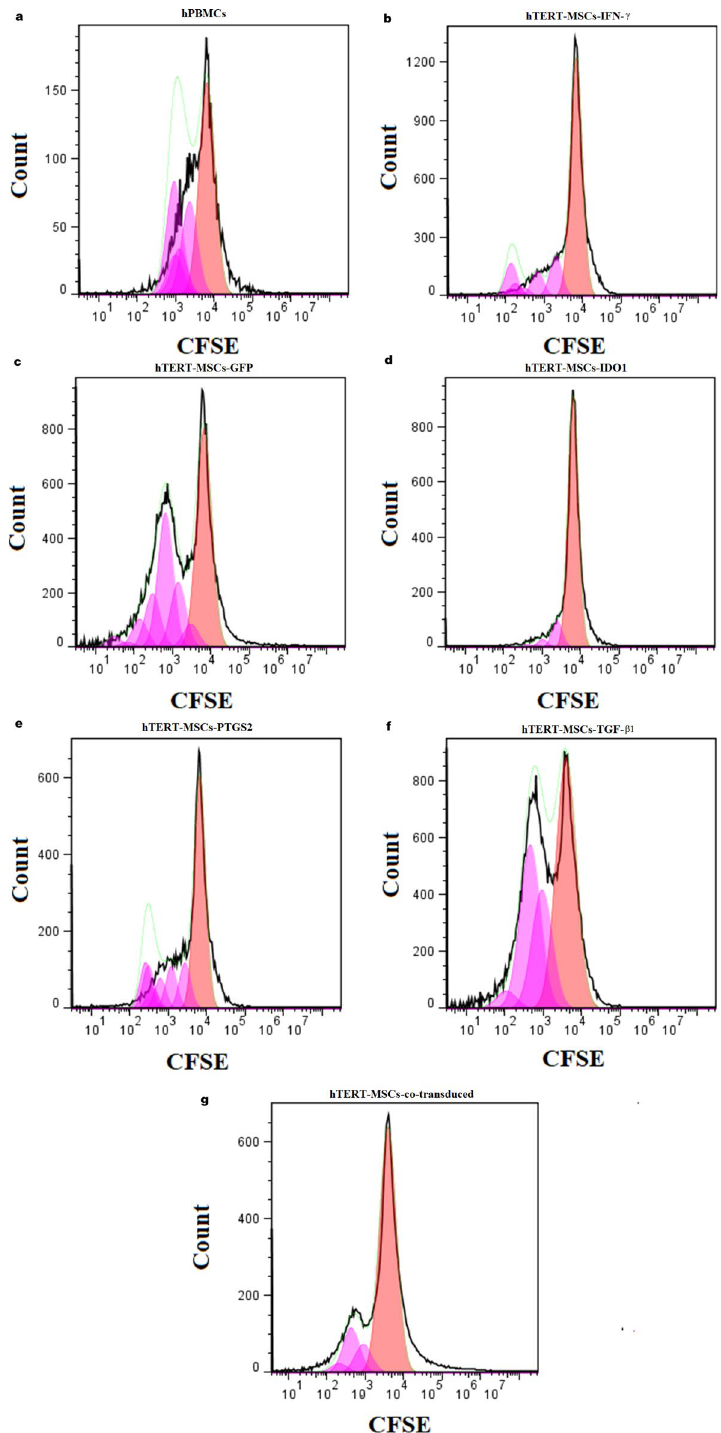
Figure 8. Lymphocyte inhibition assay (CFSE analysis). Results from flow cytometric analysis of the inhibitory effects of hTERT-MSCs against human PBMCs following 2 days of co-culture experiments. CFSE-labelled human PBMCs cultured ( a ) in the absence of any cells or in the presence of ( b ) hTERT-MSCs-IFN-γ (250 U/ ml), ( c ) hTERT-MSCs-GFP, ( d ) hTERT-MSCs-IDO1, ( e ) hTERT-MSCs-PTGS2, ( f ) hTERT-MSCs-TGF-β1 and ( g ) hTERT-MSCs-co-transduced. As shown hTERT-MSCs-IDO1 demonstrated the highest level of lymphocyte inhibition followed by hTERT-MSCs-co-transduced (PBMCs: MSCs ratio 10:1). Data were obtained by BD Accuri C6 and analyzed using FlowJo Software (version